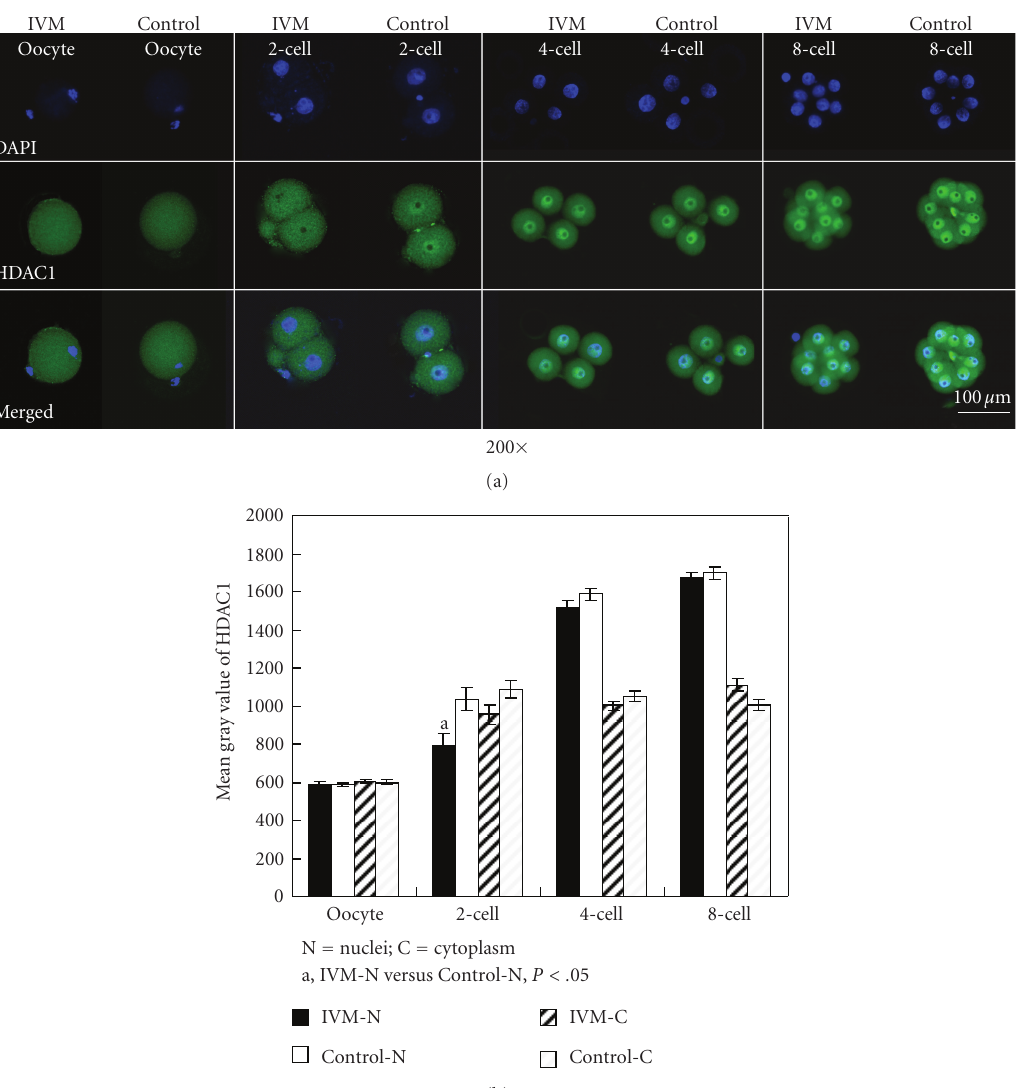
Figure 5: Fluorescence immunocytochemistry of HDAC1 in oocytes and embryos. (a) Expressions of HDAC1 in MII oocytes, 2-cell, 4-cell, and 8-cell embryos from IVM and control groups. Each sample was counterstained with DAPI (blue) to visualize the DNA. Specific rabbit polyclonal HDAC1 was detected by fluorescein-conjugated antirabbit secondary antibodies (green, FITC-labeled). Bar represents 100 μ m. (b) The gray value of GCN5 in oocytes and